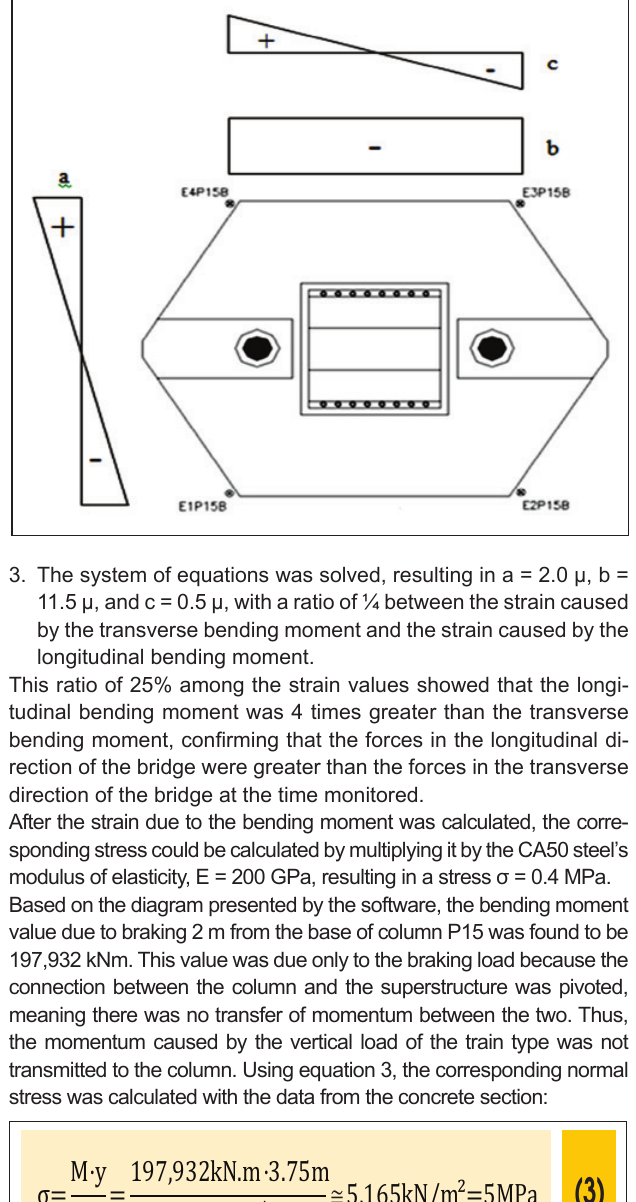
Figure 6 – Strain graphs due to the normal force and bending moments in column